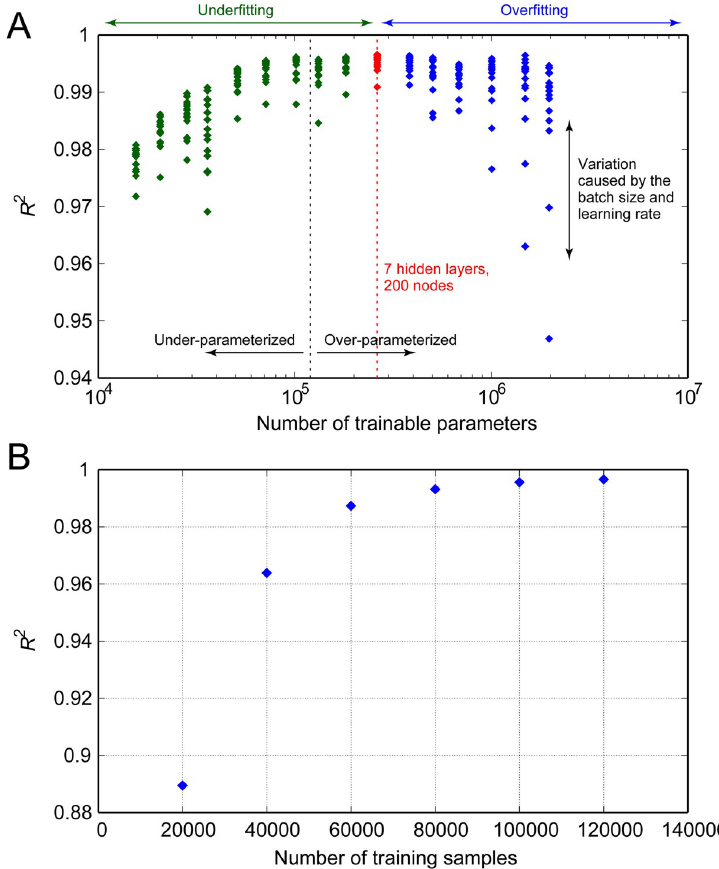
Fig 5. Changes in the R 2 score of the trained model. (A) Changes with respect to the number of trainable parameters in the deep neural networks. The number of training samples was maintained constant at 120 000, and the R 2 scores were evaluated using 40 000 test samples. Under- or over-parameterized indicate that the networks contain fewer or more trainable parameters than the number of training data, respectively. (B) Changes in the R 2 score with respect to the number of samples used for